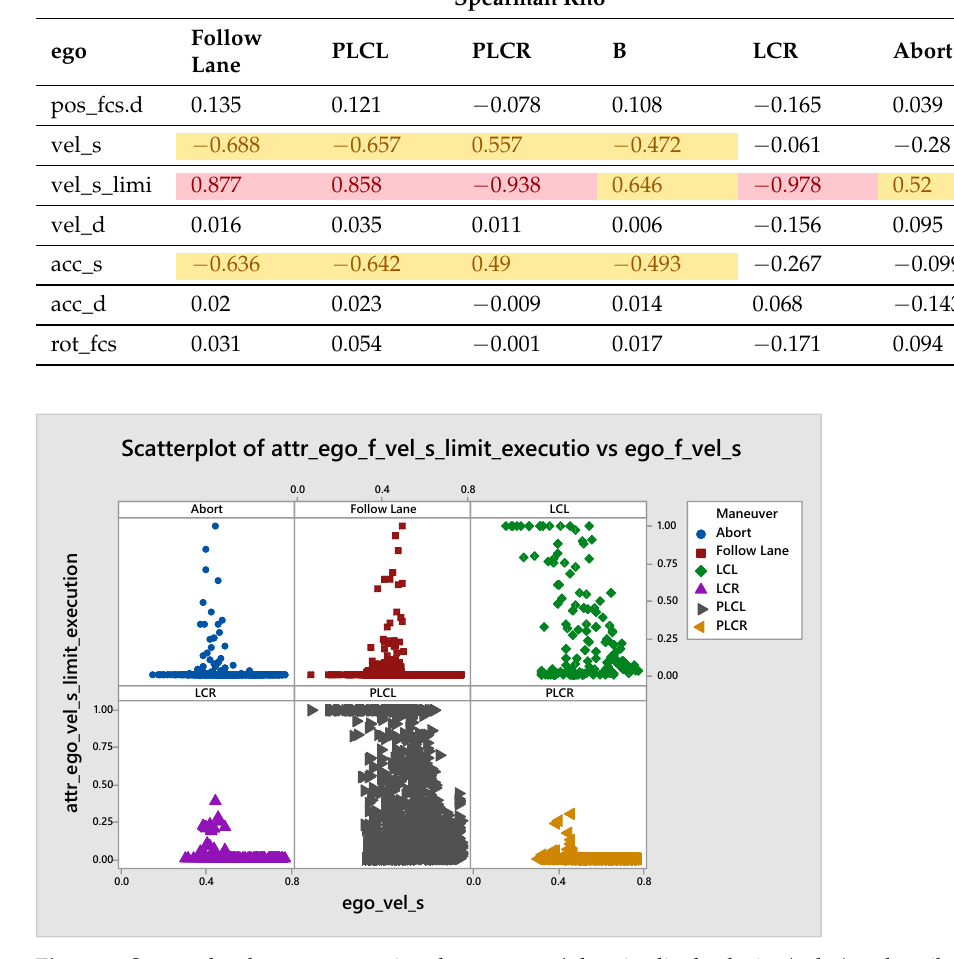
Figure 4. Scatterplot shows a comparison between ego’s longitudinal velocity (vel_s) and attributation values of vel_s_limit (velocity normalized to speed limit) for all maneuvers. Values of correlations for those examples can be found in Tables 4 and